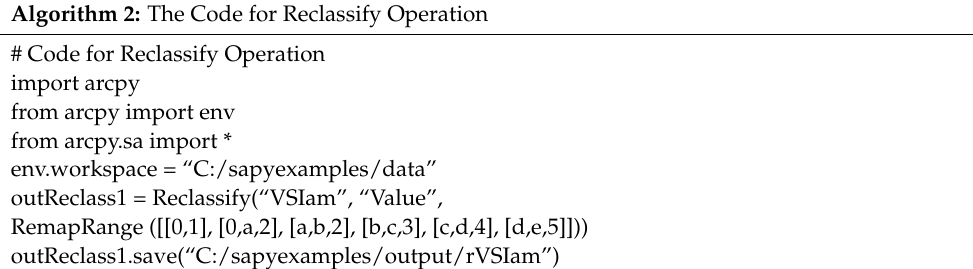
Algorithm 2: The Code for Reclassify Operation